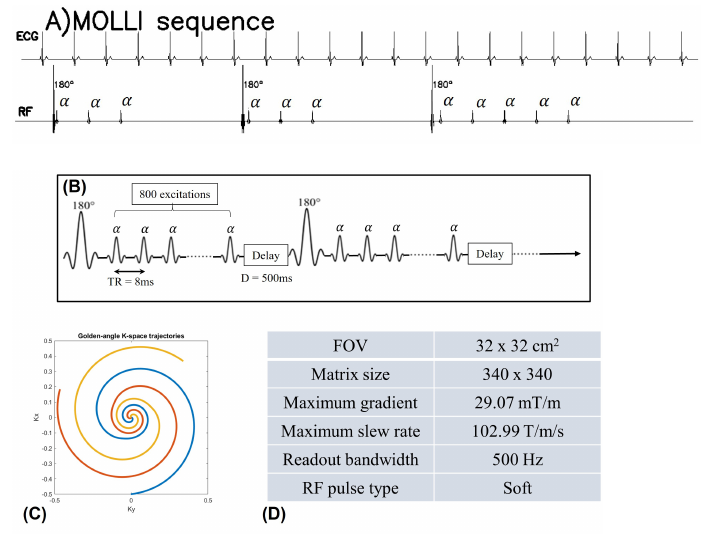
Figure 1. ( A ) shows the MOLLI sequence scheme. ( B – D ) show the inversion recovery sequence for free-breathing and ungated cardiac MRI. The acquisition is started with a 180 ◦ inversion pulse at the beginning, and following inversion pulses were applied every 6.9 s (6.4 s of data acquisition and 0.5 s of delay time). The pulse diagram is shown in ( B ). The data are continuously acquired with golden angle (137.5 ◦ ) spiral trajectories ( C ). In ( D ), we list the detailed sequence parameters. (( A ) is adopted from Figure 1 in [23] with